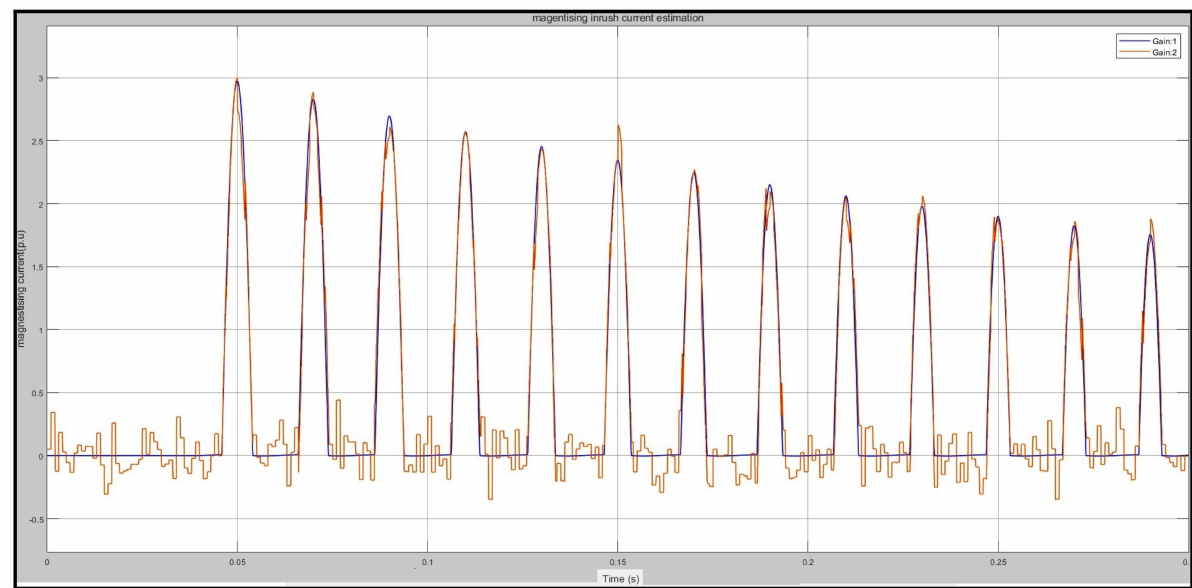
Figure 15. Estimation of inrush current by EKF algorithm (blue line is actual current and red line is the EKF estimation current).